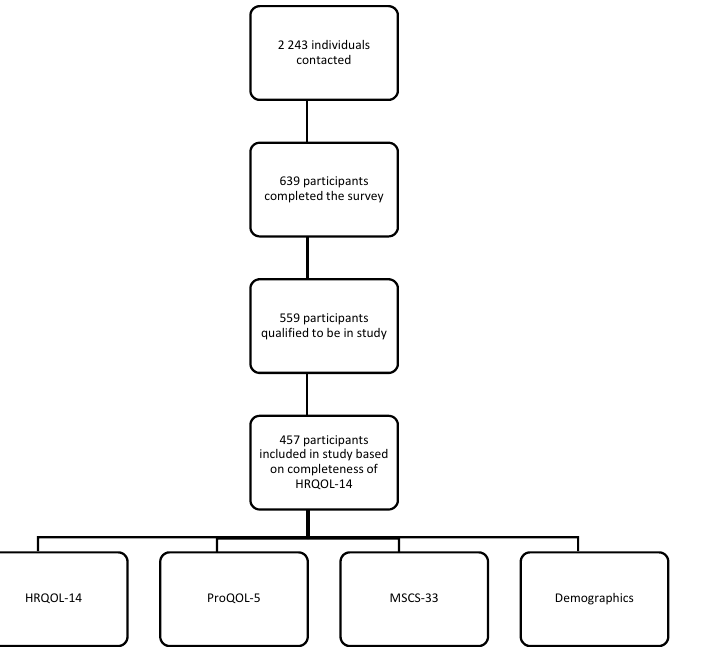
Figure 2. Participant Model. The total number of participants is shown for different parts of the study.